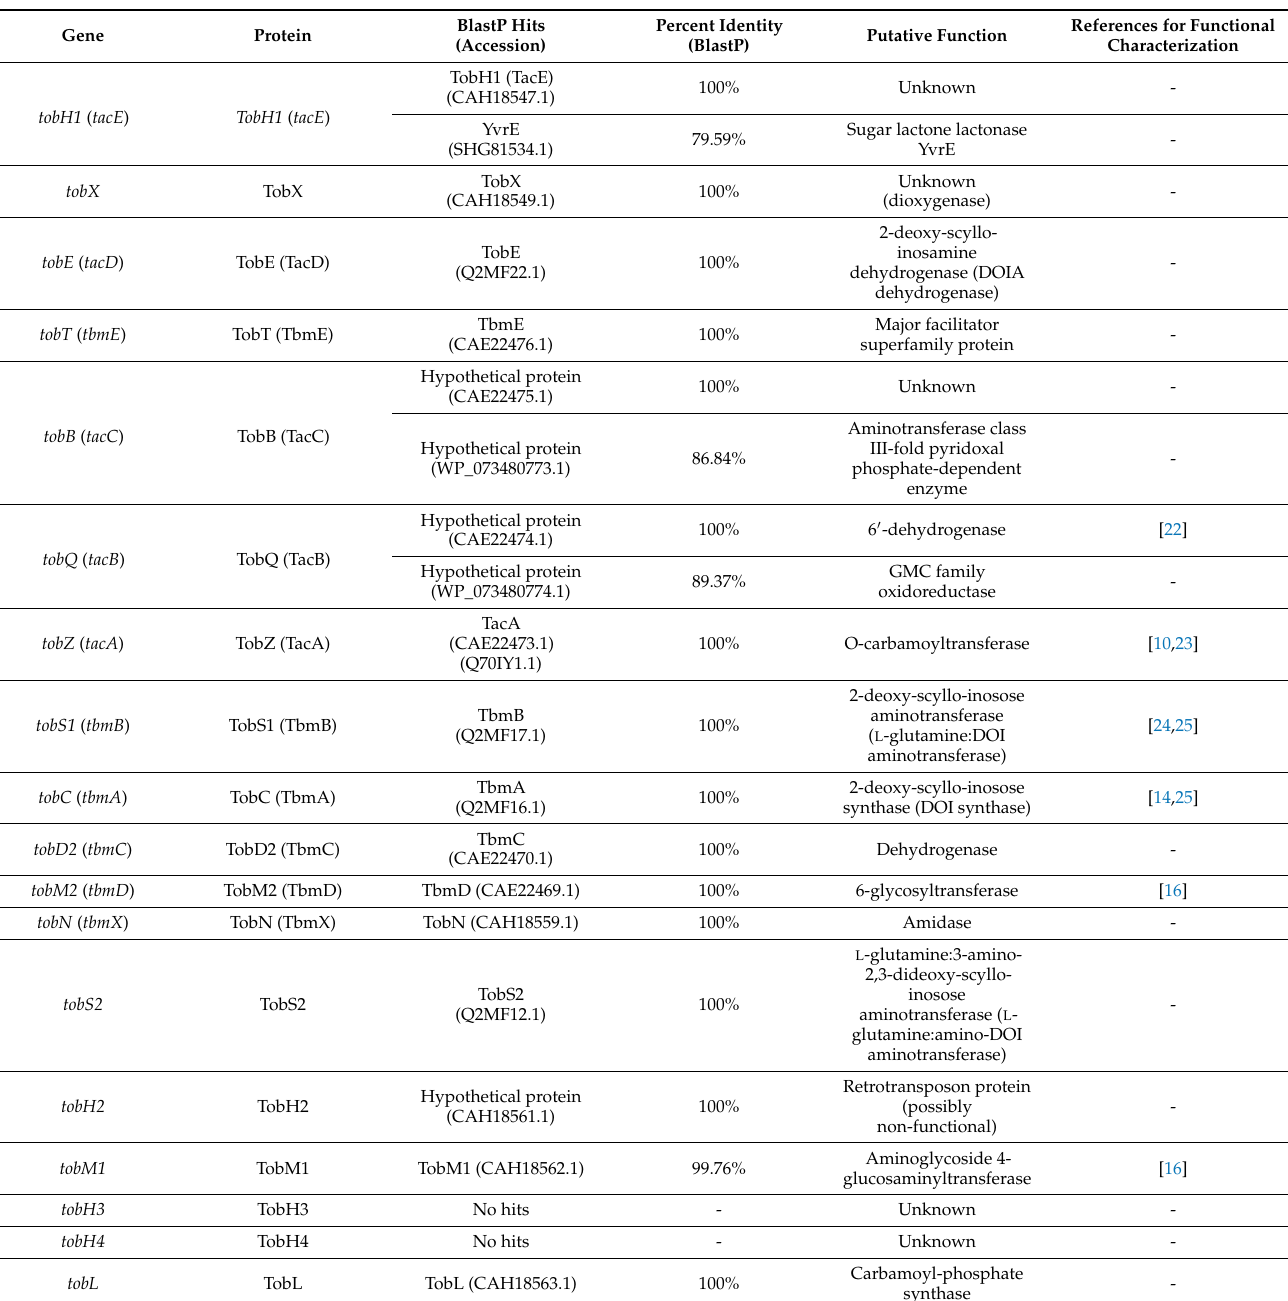
Table 1. Proposed functions of the products of genes encoded in the tobramycin biosynthetic gene cluster of Streptoalloteichus tenebrarius 2444 PS.